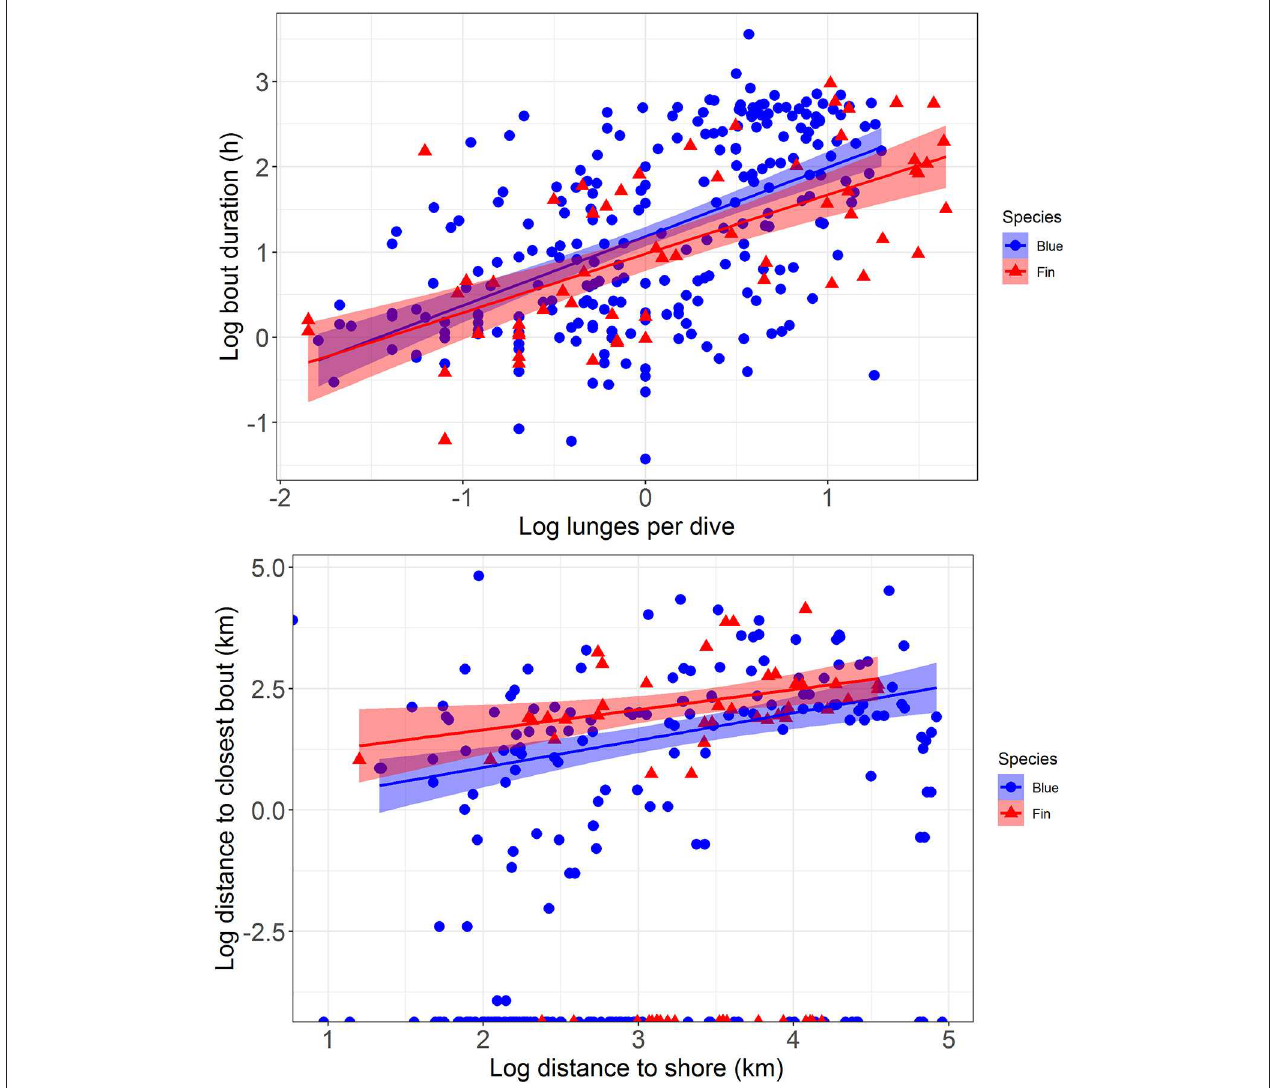
FIGURE 5 | The relationship between average number of feeding lunges per dive within a feeding bout and the duration of that bout (top) and the distance to shore of a feeding bout compared to the distance to the next closest bout (bottom) , with regression lines and 95% confidence intervals fitted to the data. Data are from blue whales (blue circles and lines) and fin whales (red triangles and lines) tracked with ADB tags off southern California in August 2014 and July